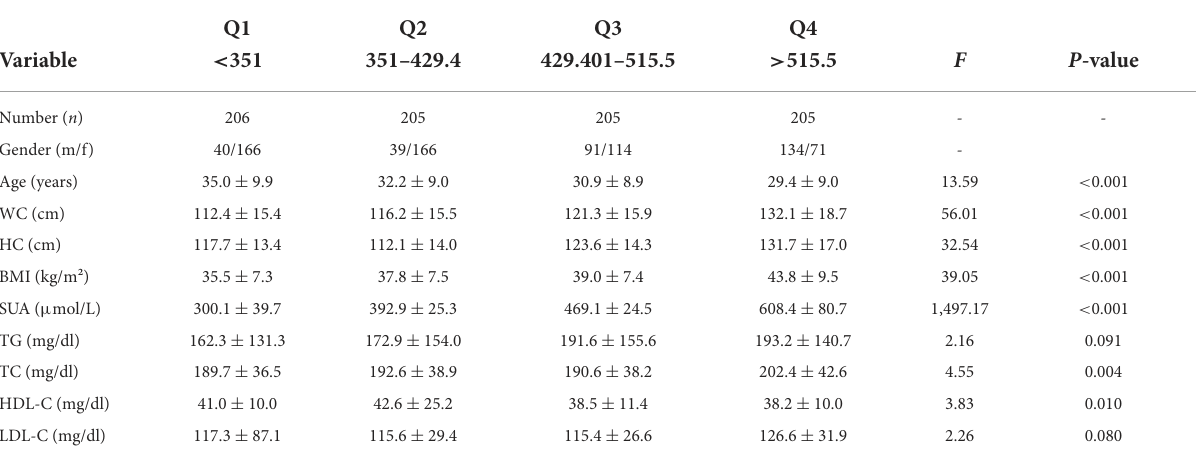
TABLE 4 Characteristics of the subjects according to SUA ( µ mol/L)